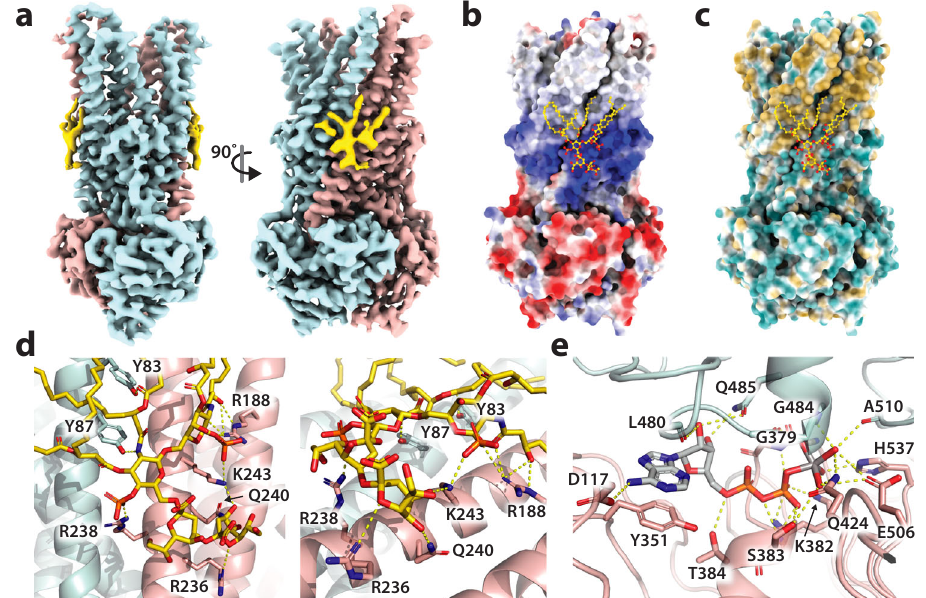
shown with hydrophilic and hydrophobic surfaces colored blue and gold, respec- tively. d DifferentviewsofKDLboundtoMsbA.KDLandinteractingresiduesshown in stick representation. Bonds are shown as dashed yellow lines. Residues are labelled. e ViewoftheboundADP·VO 4 andinteractingresiduesshownasdescribed in d